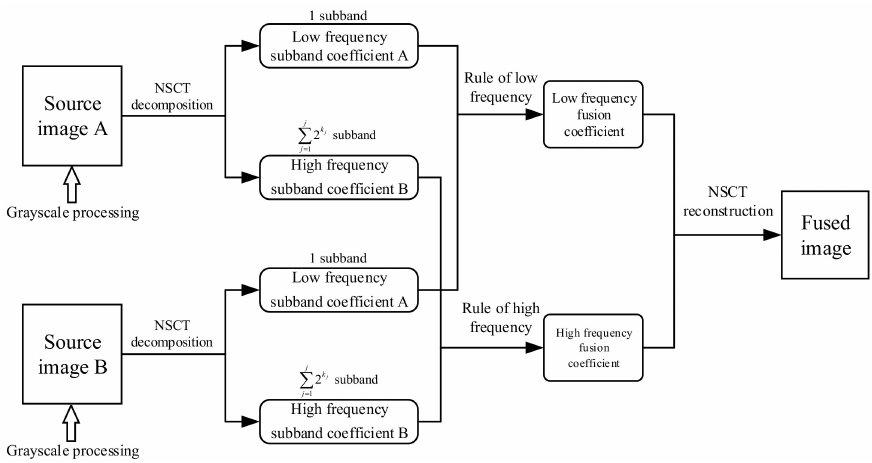
Figure 10. NSCT image fusion